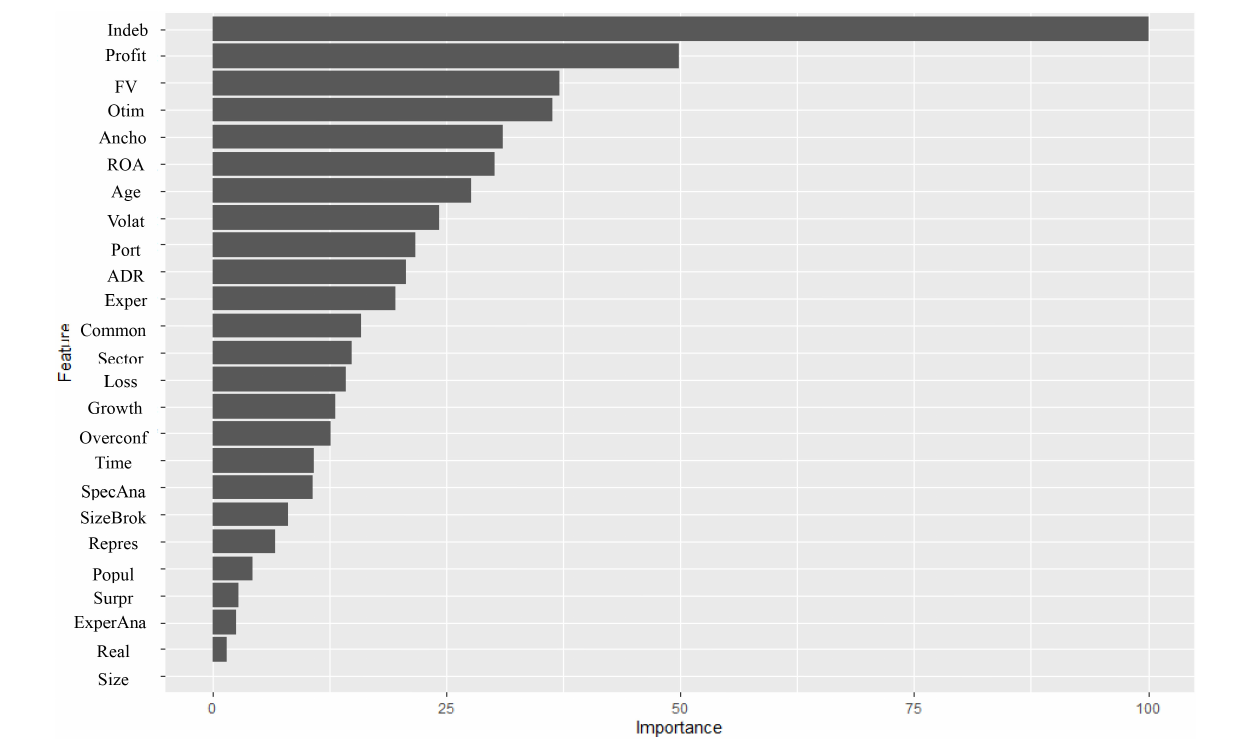
FIGURE 2 | Importance of variables in Ordinary Least Squares (OLS). TABLE 5 | Regression in Random Forest (RF) in 2019. General Otim Ancho Overnconf Repres Real Common